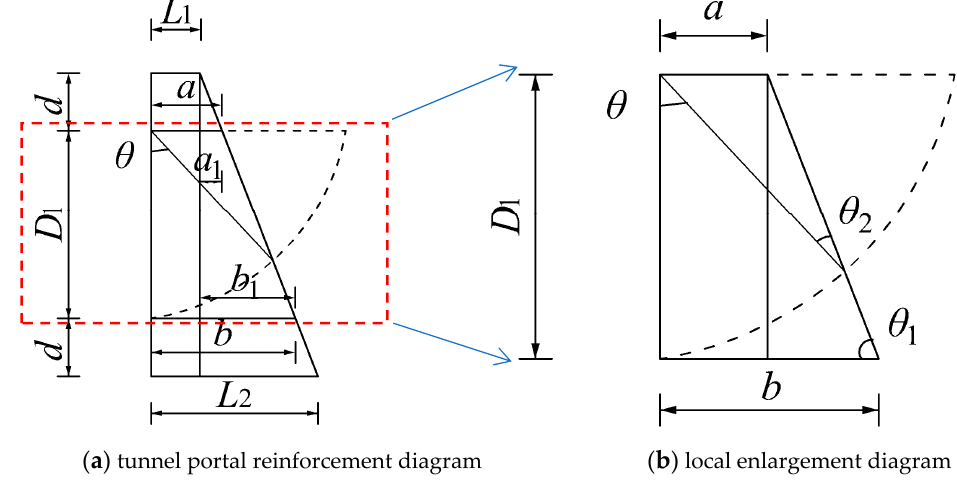
Figure 6. The trapezoidal freezing soil mass The trapezoidal freezing soil mass, which is shown in Figure 6a, is separated from Figure 5. The dimensions in Figure 6a have the following relationship.